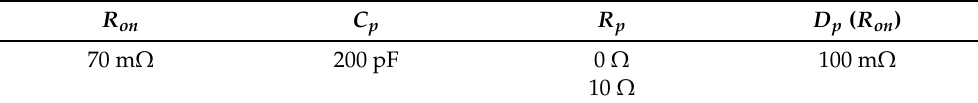
Figure 18. Drain current through the high side (HS) transistor (see Figures 15 and 16) using a smooth switching behavior for different values of R p . Table 3. Parameters of the transistor model depicted in Figure 16. Two different values for R p are considered to study their impact on the conducted